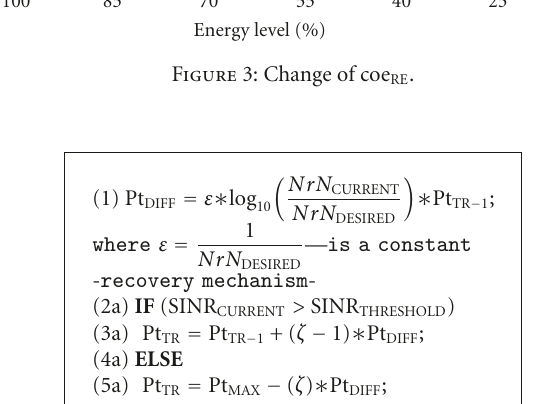
Figure 3: Change of coe RE .